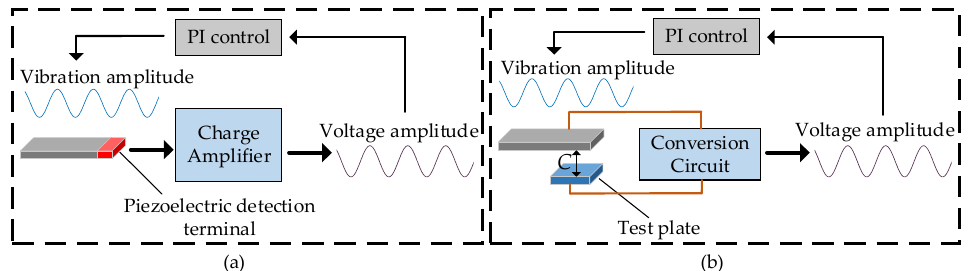
Figure 2. Piezoelectric and capacitive amplitude detection and control methods: ( a ) piezoelectric feedback amplitude control method; ( b ) capacitive feedback amplitude control method.